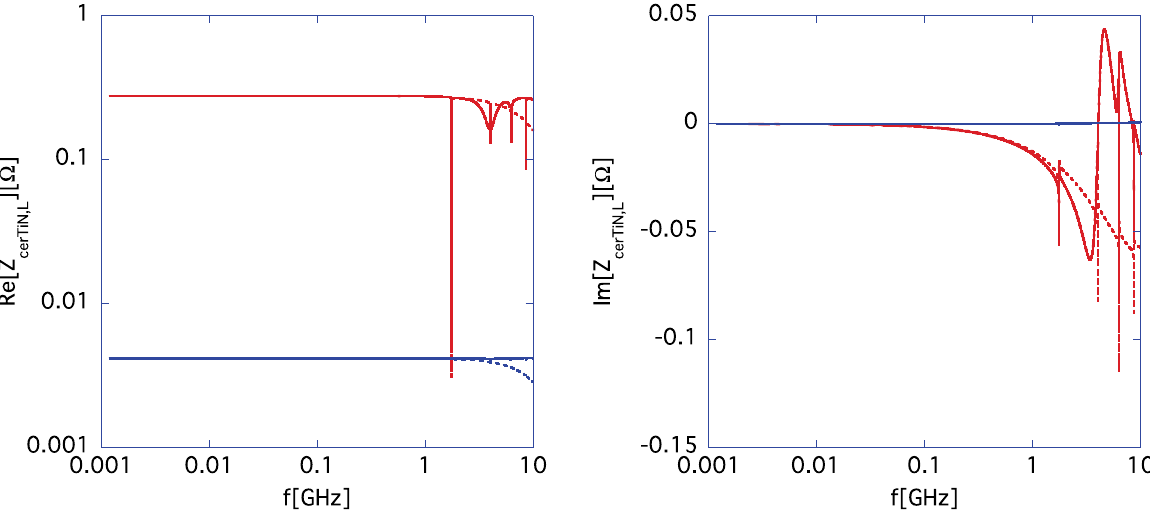
FIG. 2. Longitudinal impedances of the ceramic break with the TiN coating. The red and blue lines show the cases for a ¼ 65 mm, a 2 ¼ 70 mm, g ¼ 10 mm, and t ¼ 15 nm andfor a ¼ 65 mm, a 2 ¼ 70 mm, g ¼ 10 mm, and t ¼ 1 μ m, respectively.The solidanddashed